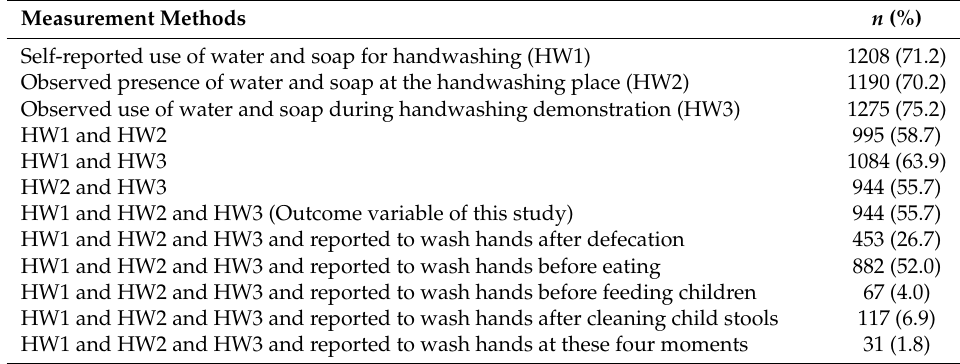
Table 2. Handwashing (HW) with soap estimated by self-reports, direct observations, and a composite measure, n =